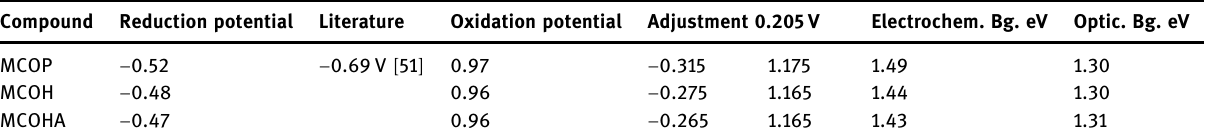
Table 4: Values obtained from the voltammograms